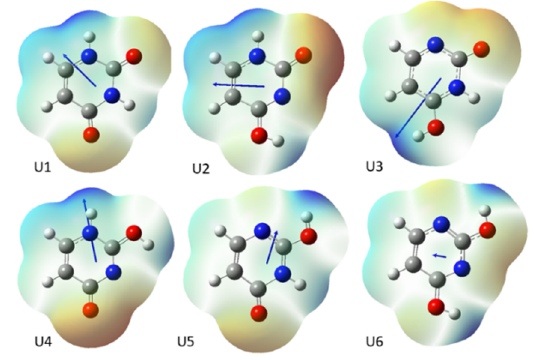
Figure 3. Dipole moment orientation for uracil tautomers combined with calculated maps of electrostatic potential.